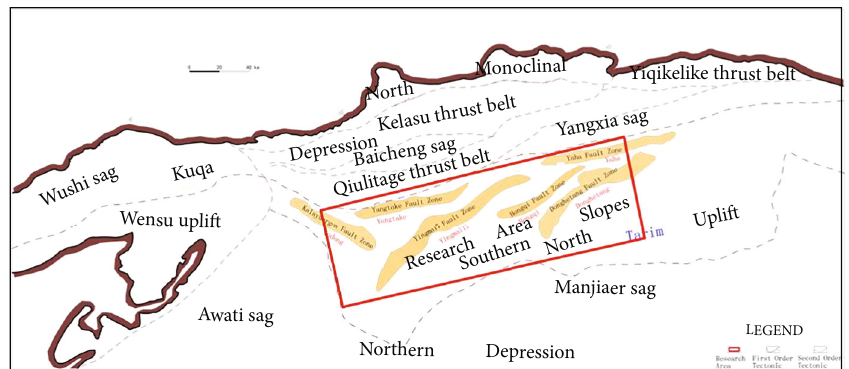
Figure 1: Structural location of the western Tabei area in the Tarim